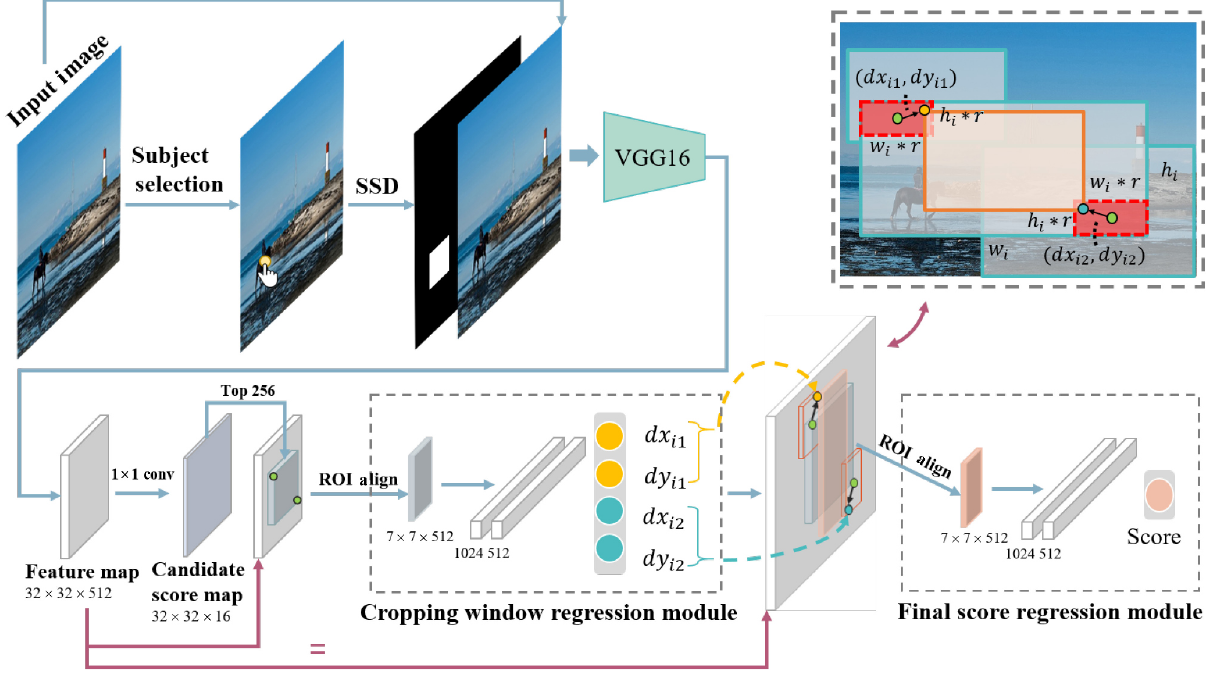
Fig. 4 Inference pipeline of SAC-Net. For an input image, SSD is used to obtain the subject mask after the user selects the subject. The concatenation of the mask and the image are then fed into SAC-Net. SAC-Net has three sub-modules. The candidate score map regression module extracts a feature map and convolves it to obtain a candidate score map, in which the top 256 anchors with highest score are selected and ROIaligned. The cropping window regression module obtains fine-tuning offsets for the 256 anchor boxes, which are ROIaligned again with fine-tuned boxes on the feature map. The final score regression module computes the final composition score of each fine-tuned box. Top right: example of fine-tuning an anchor